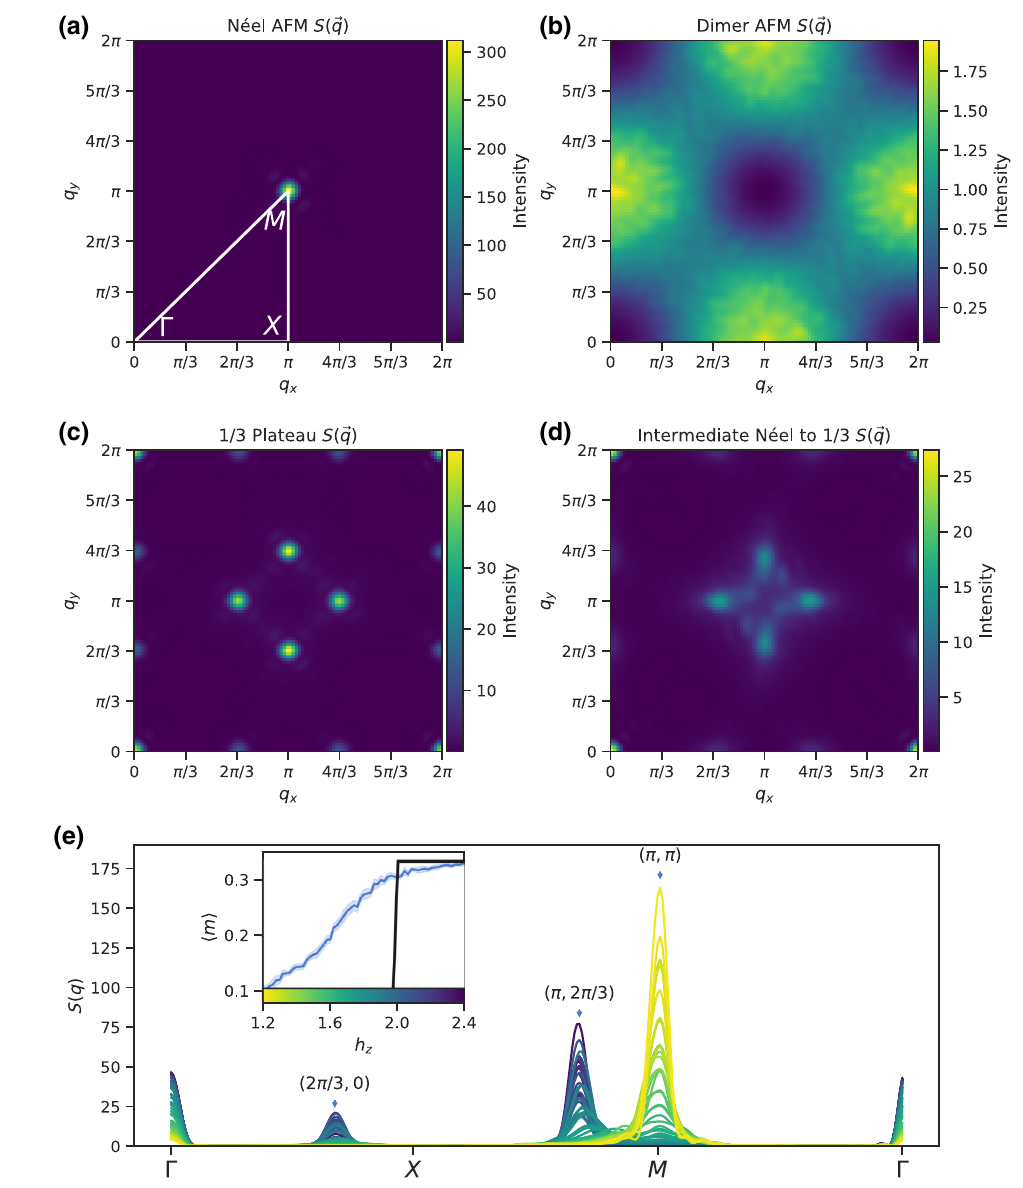
FIG. 4. Static structure factors in equilibrium and at criticality. (a) Structure factor of the Néel AFM phase at J 1 = J 2 = 1, h z = 0. The high symmetry points of this model are labeled in white along with a cut path used in (e); these points are ( q x = 0, q y = 0 ) , = π , q = 0 ) , and ( q = π , q = π) . (b) Structure factor of the dimer AFM phase at J ( q x y x y plateau phase at J 1 = J 2 = 1, h z = 2.1. (d) Structure factor in the transition between Néel AFM and 1 of the 1 3 J 1 = J 2 = 1, h z = 1.8. (e) A cut along the symmetry points shown in (a) of the structure factor through the Néel to plateau transition. The inset figure shows the color scale corresponding to the longitudinal field across the phase transition at J 2 / J 1 = 1.